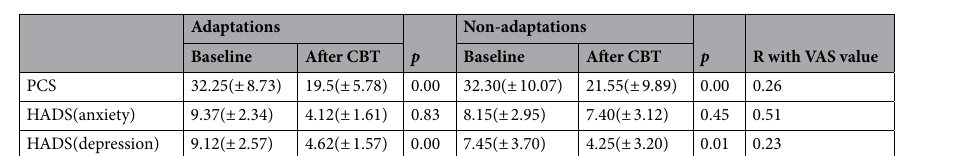
Figure 2. Examination for intelligence level. The WAIS-IV results in each group are shown. There were no significant between-group difference in overall test IQ, perceptual reasoning, working memory, and processing speed, which were indicative of an average3 intellectual level. However, in the non-adaption group, the verbal comprehension index (83.35 [± 11.70]) was determined as a dull normal level compared with the same-age segment; moreover, there was a significant between-group difference (p < 0.01). Compared with the adaptation group, the non-adaptation group may have significantly lower verbal comprehension (i.e., language communicating ability to understand or express the language).